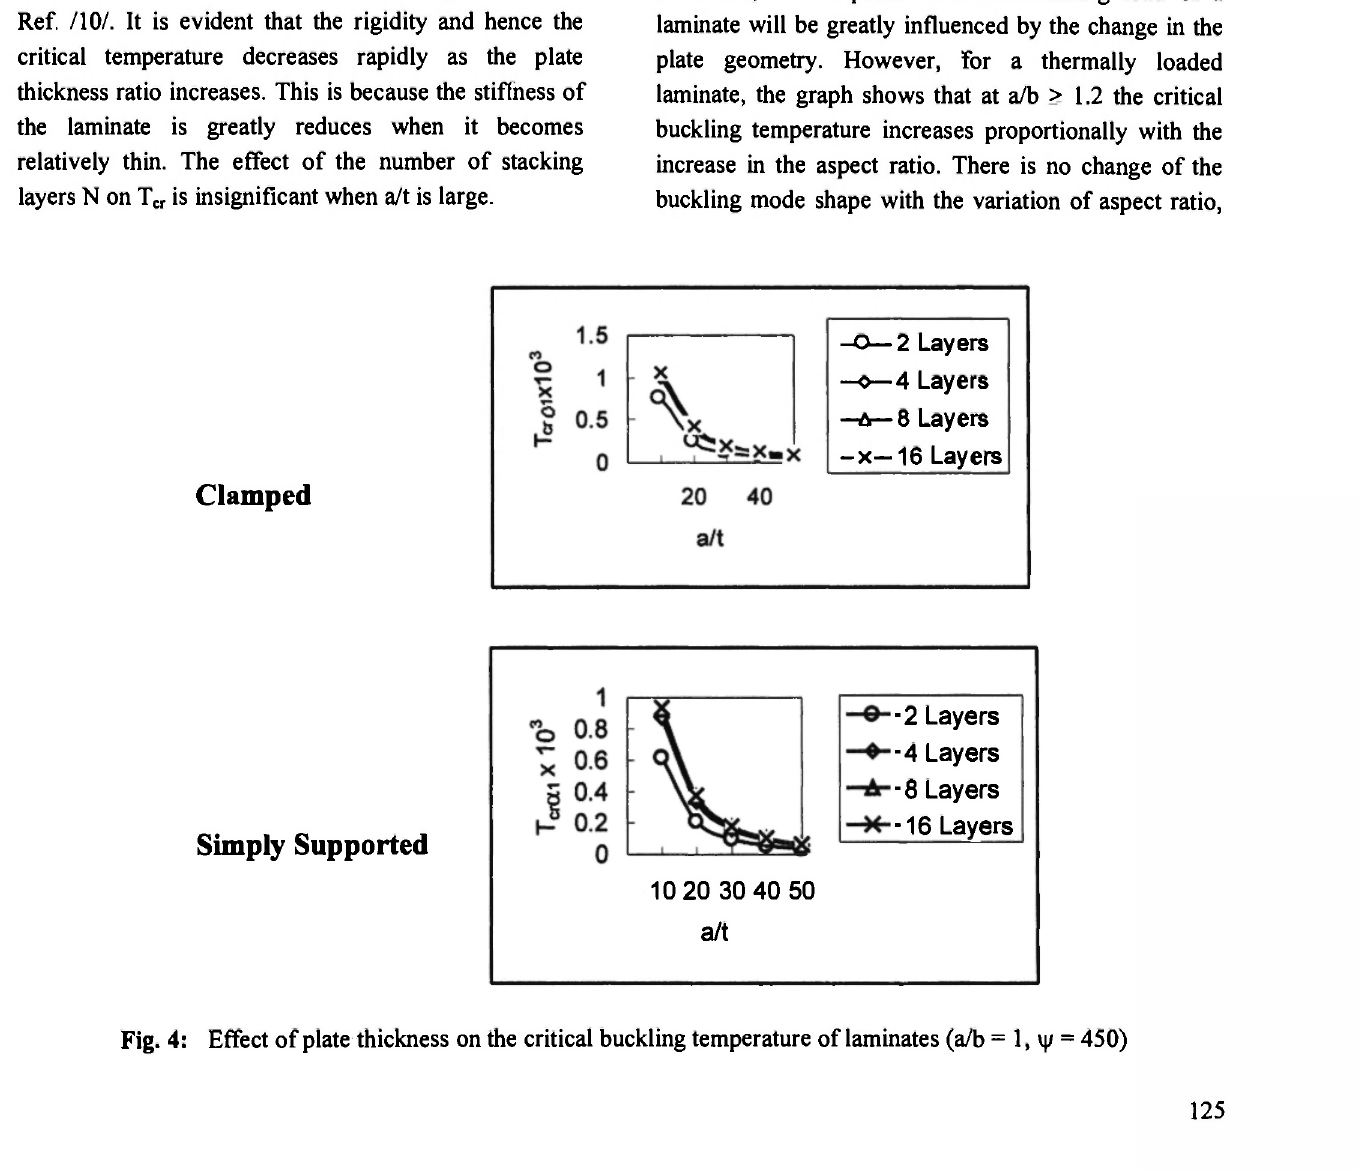
Fig. 4: Effect of plate thickness on the critical buckling temperature of laminates (a/b = 1, ψ =